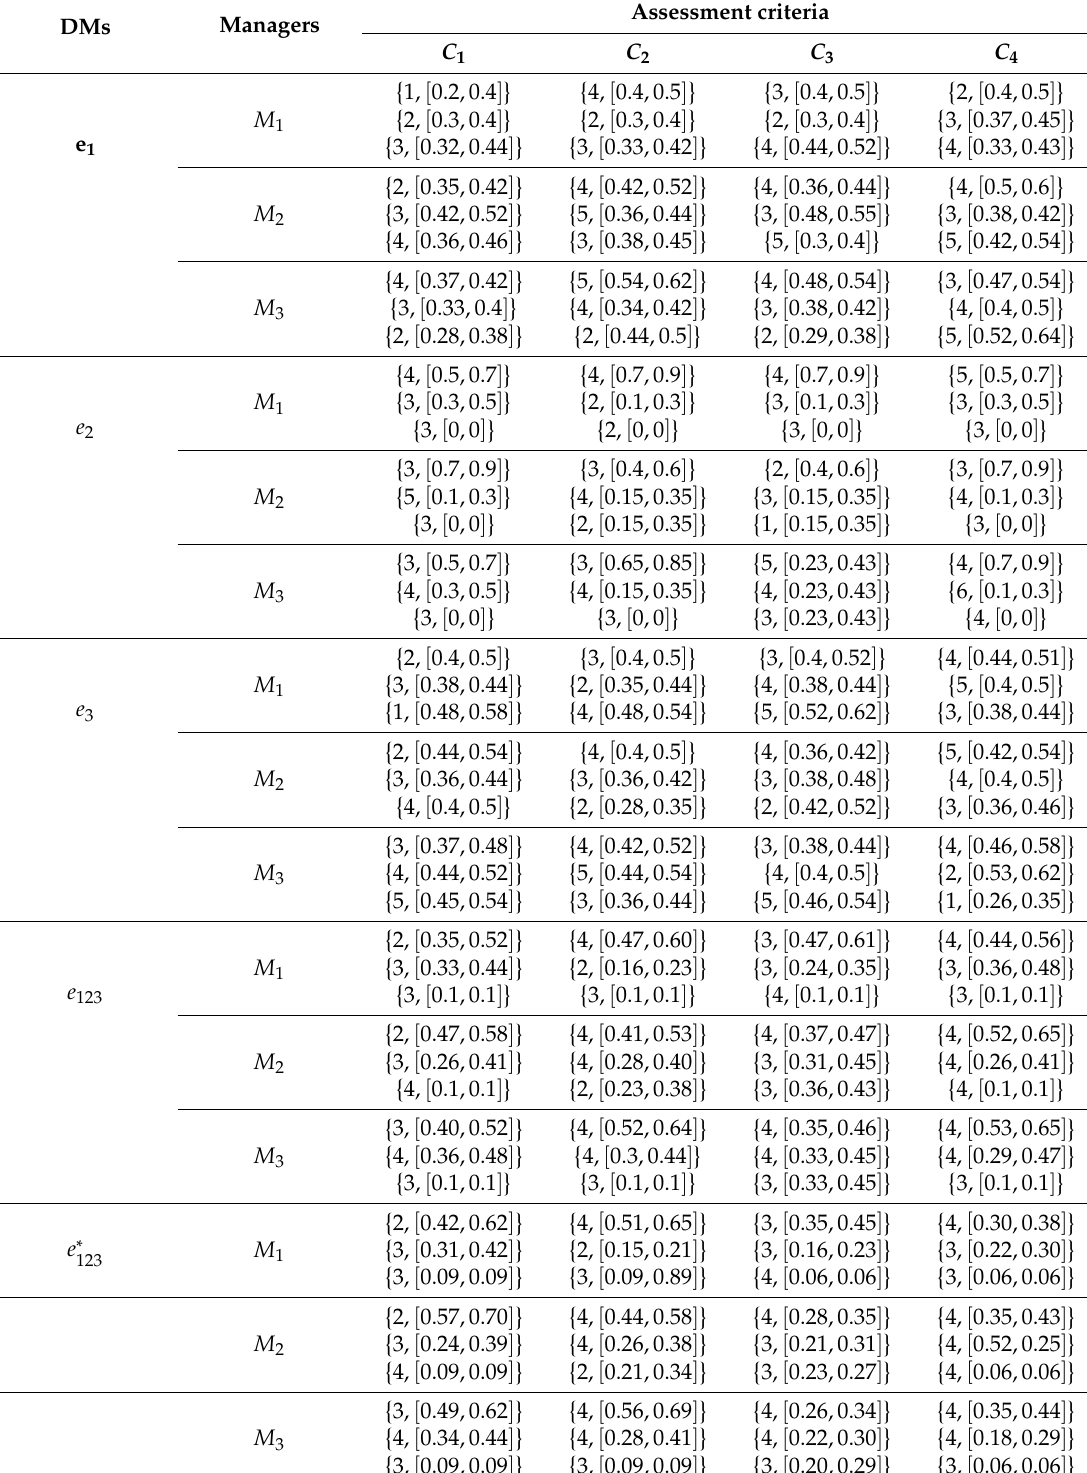
Table 1. Decision matrix with IVPLTS for renewable energy source (RES) selection.